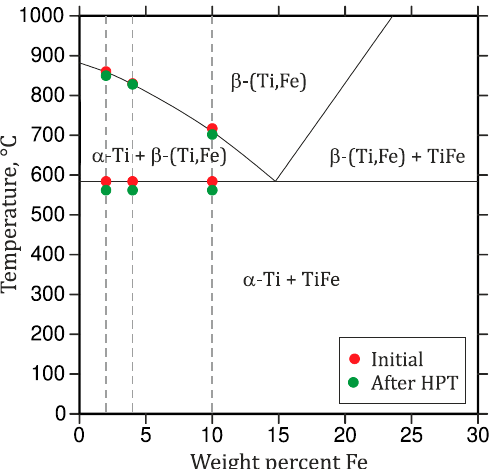
Figure 6. Partial phase diagram of the Ti-rich corner of the binary Ti–Fe system. The circles indicate the measured phase transition temperatures (DSC) of the samples in the initial state (red) and after deformation by HPT (green).